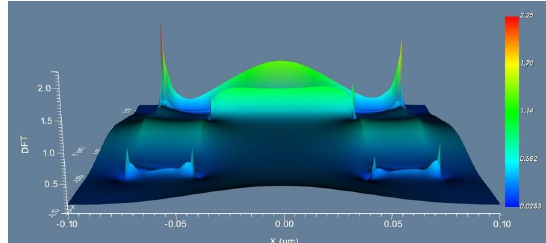
Fig. 8. Electromagnetic field intensity on the substrate around the resonator for silver U-shape elements metasurface with – W = 10 nm, Wx = 110 nm; Wy = 90 nm parameters; at the Rhodamine 6G emission